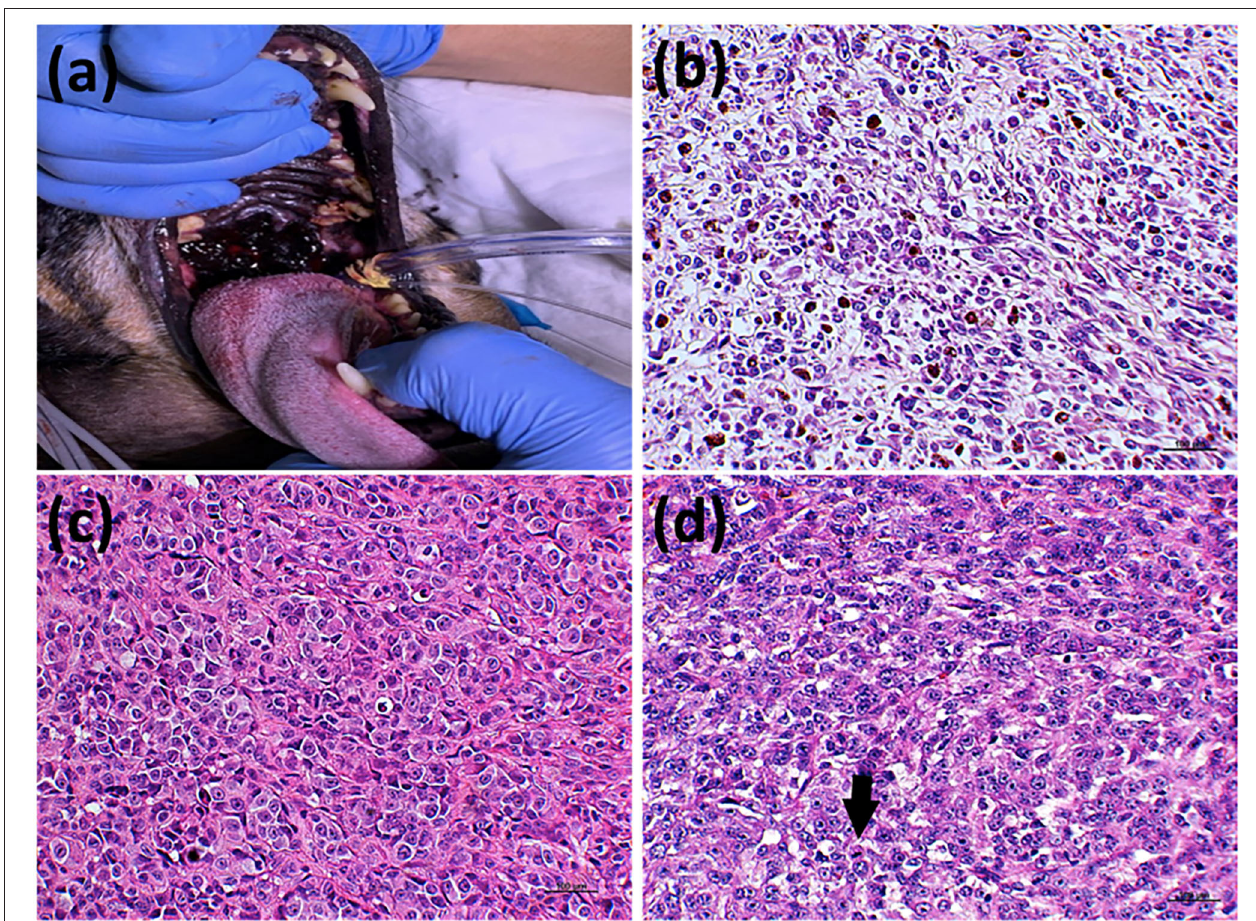
FIGURE 1 | Prognostic criteria for canine oral melanomas. (a) Patient with an oral melanoma in the palate with high degree of pigmentation. The degree of pigmentation has a direct 661 relation with patient’s prognosis. Patients with heavily pigmented tumors show better outcomes. (b) Histological evaluation of a canine oral melanoma with < 50% of pigmented cells. (c) Histological section of a canine oral melanoma with a marked nuclear atypia, also considered a poor prognostic factor. (d) Canine oral melanoma histological section evidencing a mitosis (arrows), one of the most important prognostic factors. Hematoxylin and eosin counterstaining,